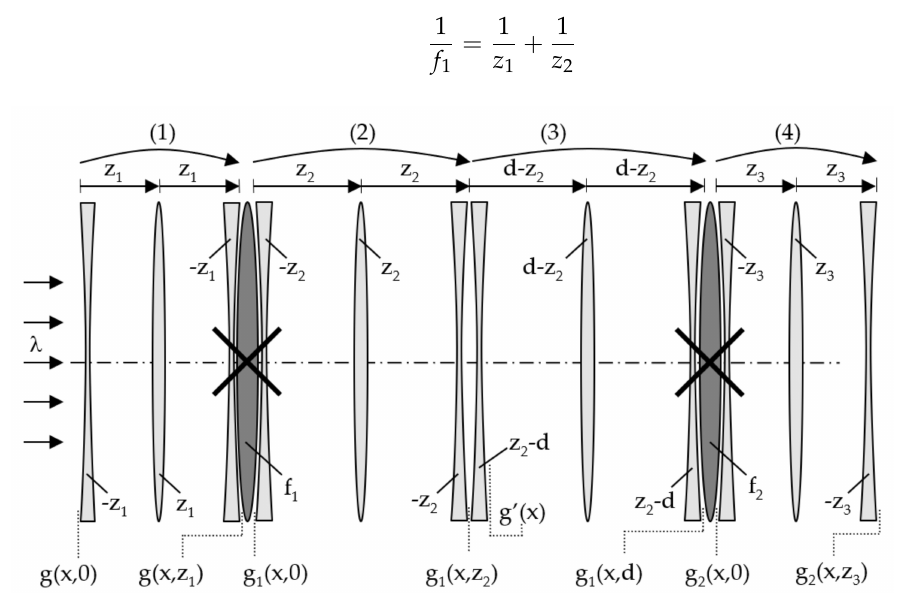
Figure 5. Diffraction-based modeling of the system of Figure 4 by the lenses-based approach of Figure 3a. Initial lenses are in dark gray, and the lenses caused by diffraction are in light